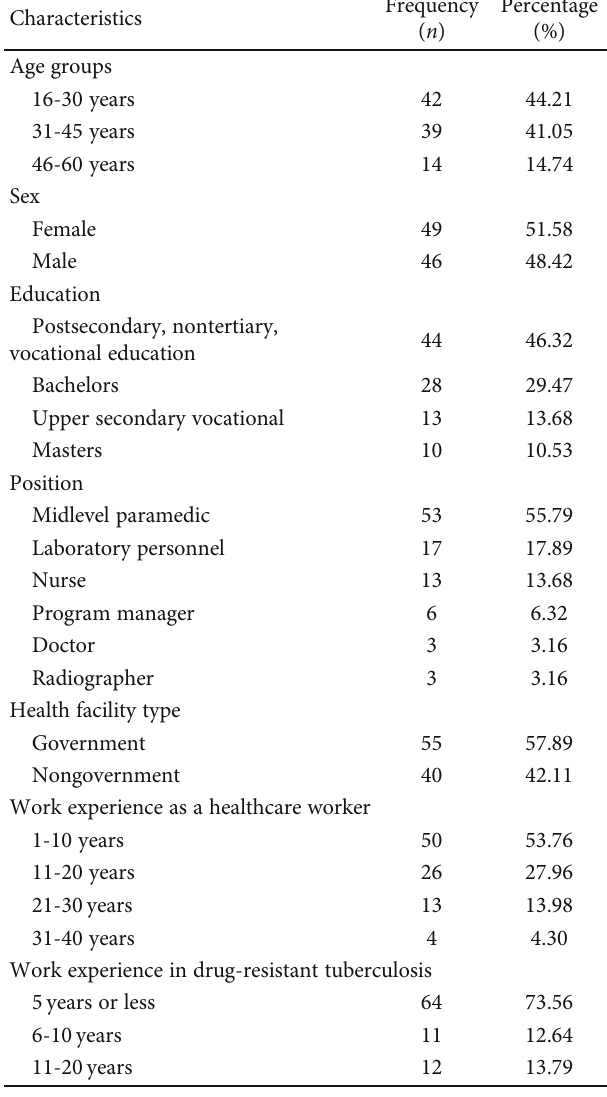
Table 1: Characteristics of study